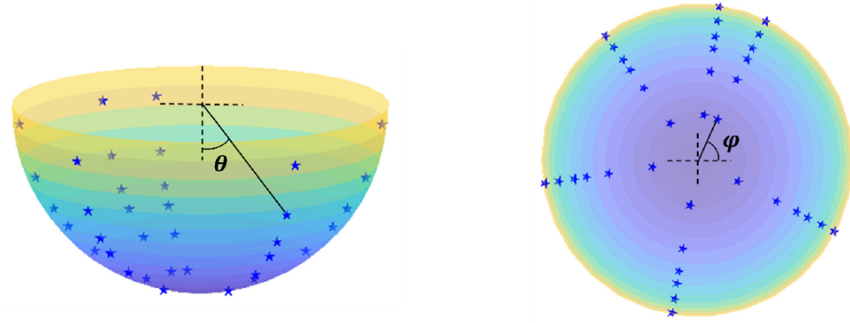
Figure 9. Distribution map of 36 different testing positions.